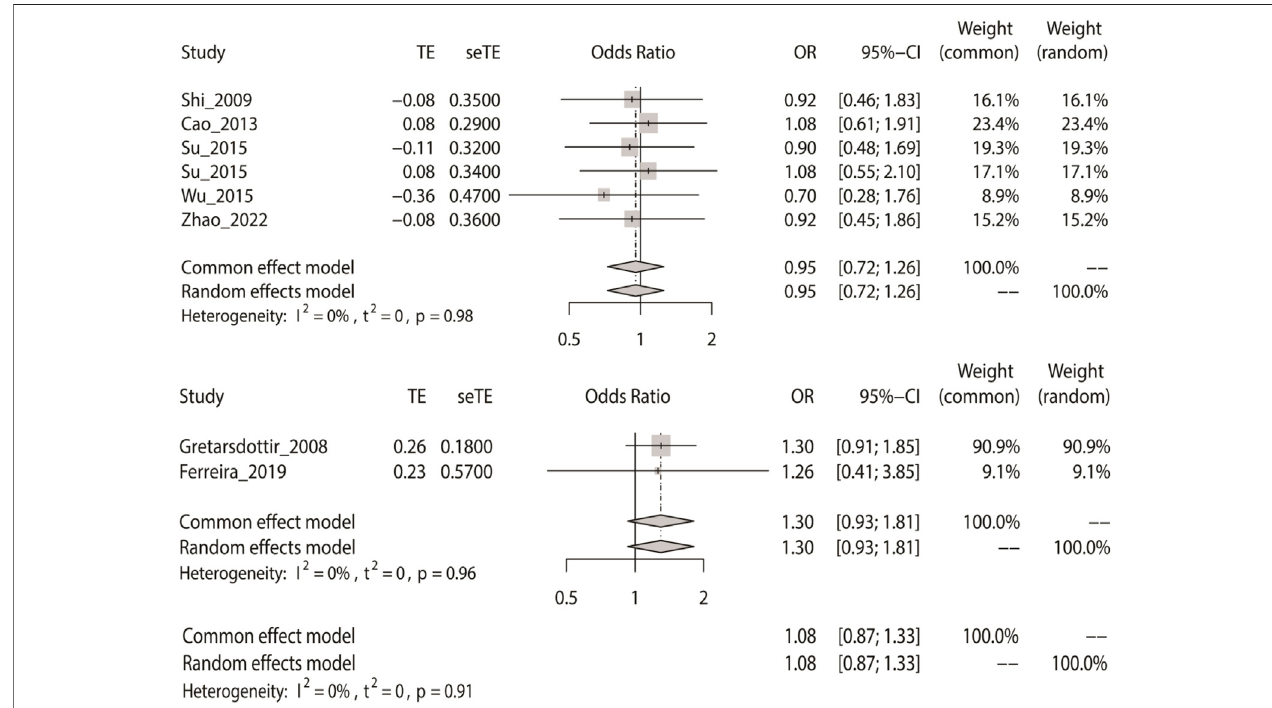
FIGURE 4 | Fixed-effect meta-analysis of the dominant model for rs2200733 and rs6843082 in the Asian, non-Asian, and pooled populations.